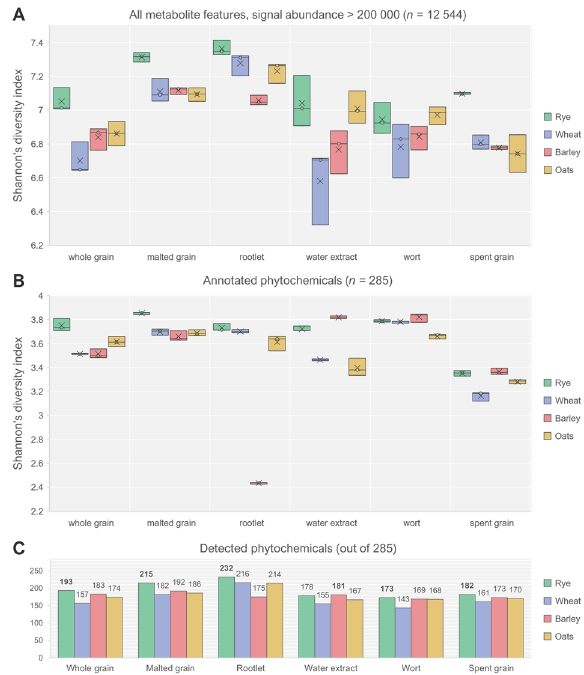
Fig. 5 The metabolite and phytochemical diversity of the studied cereal samples. a Shannon ’ s diversity index of all the detected metabolite features with signal abundance over 200,000 counts (box plot with fi rst and third quartiles, average [×] and median [ ○ ] values). b Shannon ’ s diversity index of all the annotated phyto- chemicals. c The richness (number of detected phytochemicals) in each sample type (signal-to-noise ratio > 5 considered as limit of detection).